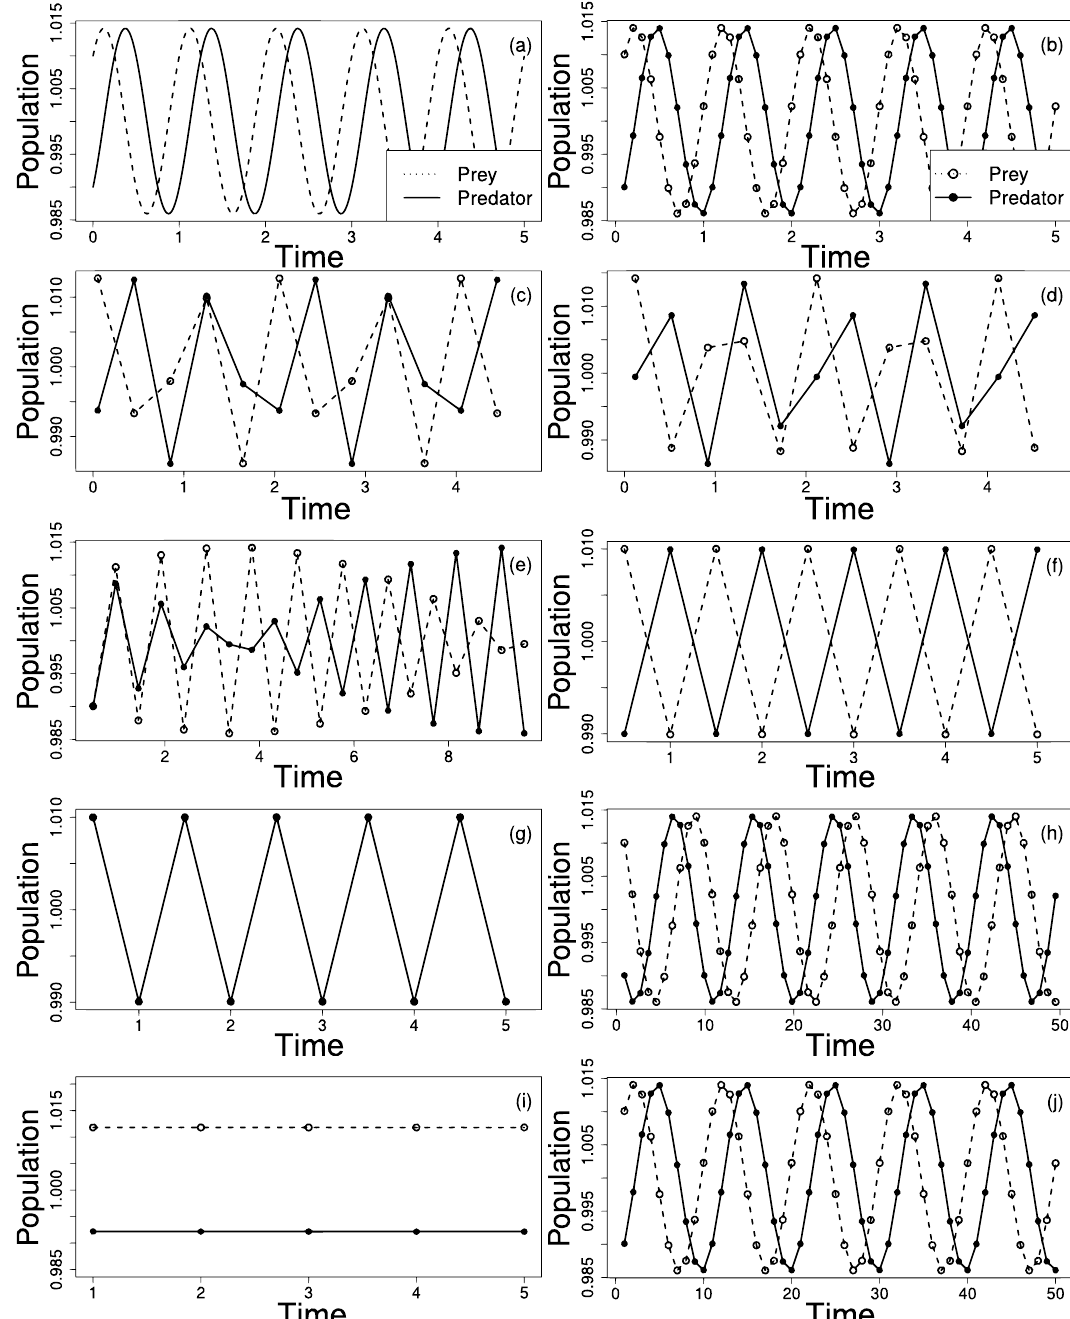
Figure 2. ( a ) Prey (dashed line) and predator (full line) population cycles obtained with the Lotka–Volterra model (LVM), with oscillation period τ = 1. The LVM dynamics can generate different patterns due only to sampling rate effects. In the above panels, prey and predator abundances are represented by an empty and full circles, respectively. ( b ) T s = 0.1, the time series correctly retrieve the LVM behavior. ( c ) T s = 0.4, peaks seems to synchronize every two cycles. ( d ) T s = 0.4, same sample period as in ( c ) but with different pattern. ( e ) T s = 0.48, synchronous and anti-synchronous patterns are present in the same series. With T s = 0.5 (Nyquist limit), two possible behaviors appears: ( f ) anti-synchronous cycles or ( g ) fully synchronized. ( h ) T s = 0.9, an inversion and an extension of cycle period may be interpreted as preys eating predators. ( i ) T s = 1 no oscillations are observed. ( j ) T s = 1.1, the original dynamics is retrieved but with extended cycle